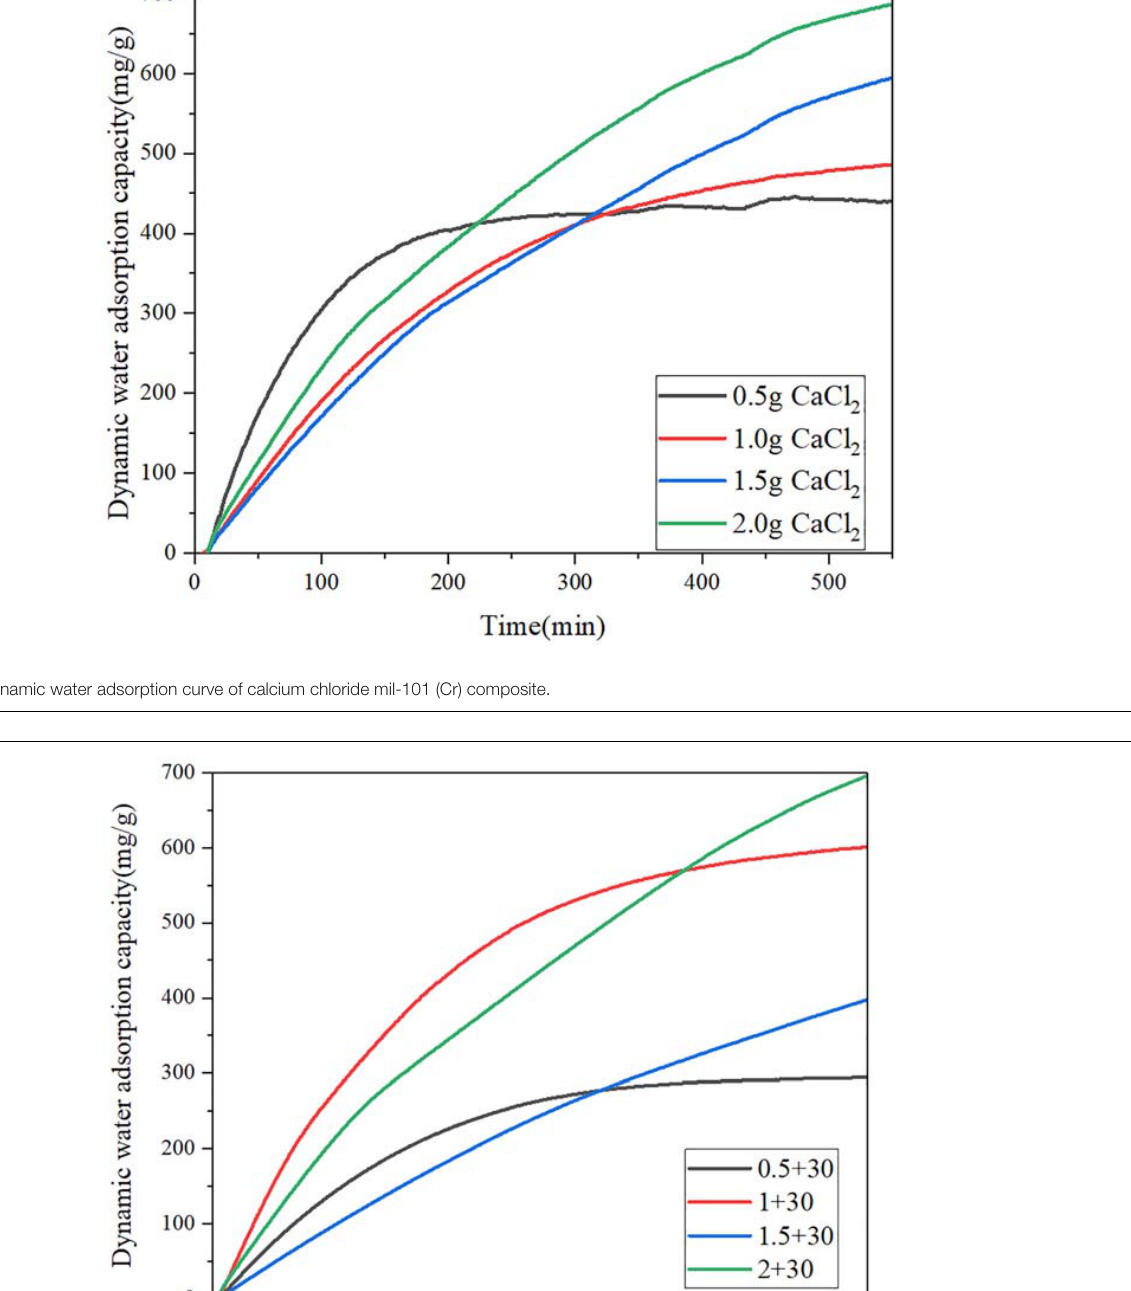
macro morphology and quality of the material. The curve